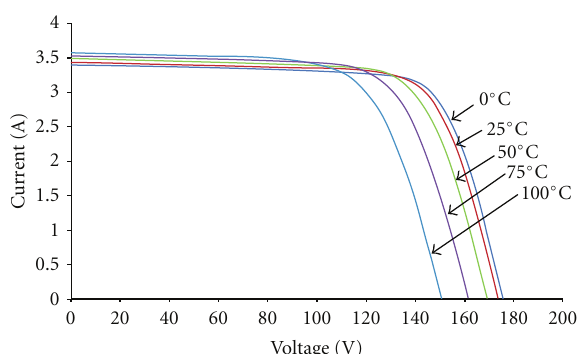
Figure 2: The I - V characteristic curve of solar cells under di ff erent temperature.